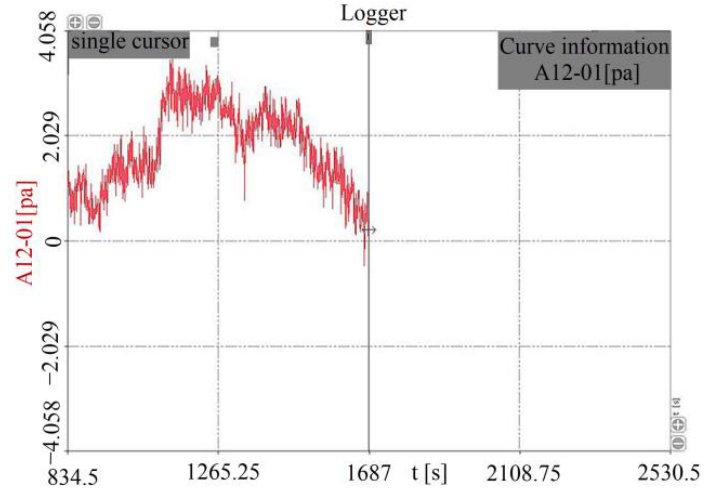
Figure 8. Earth pressure curve.